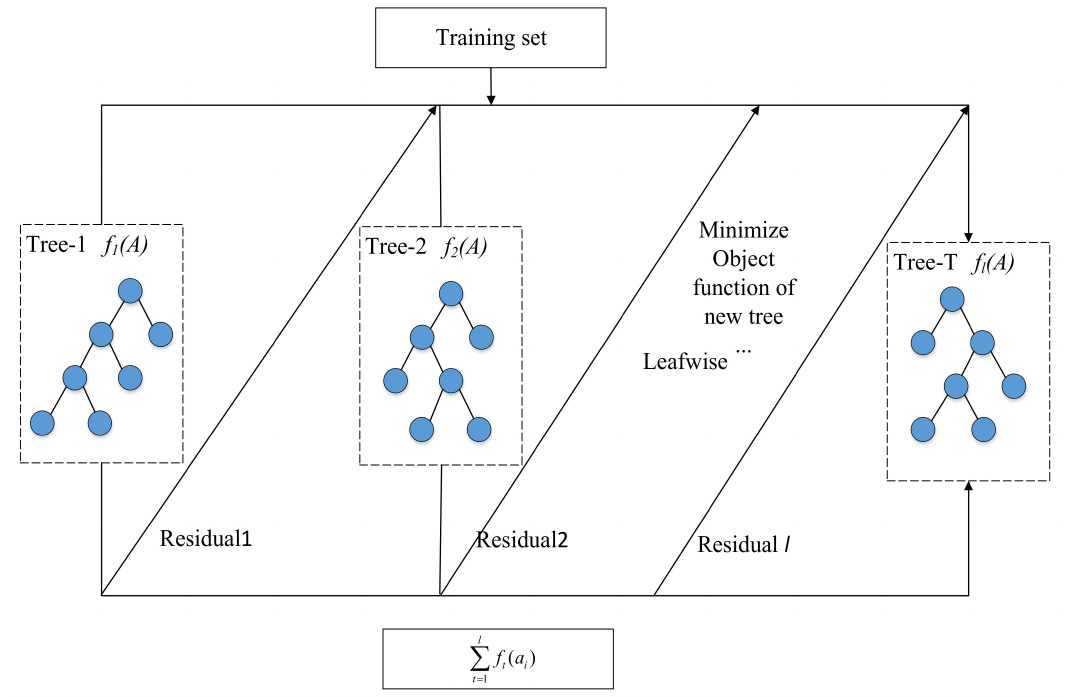
Figure 3. LightGBM model computing process.